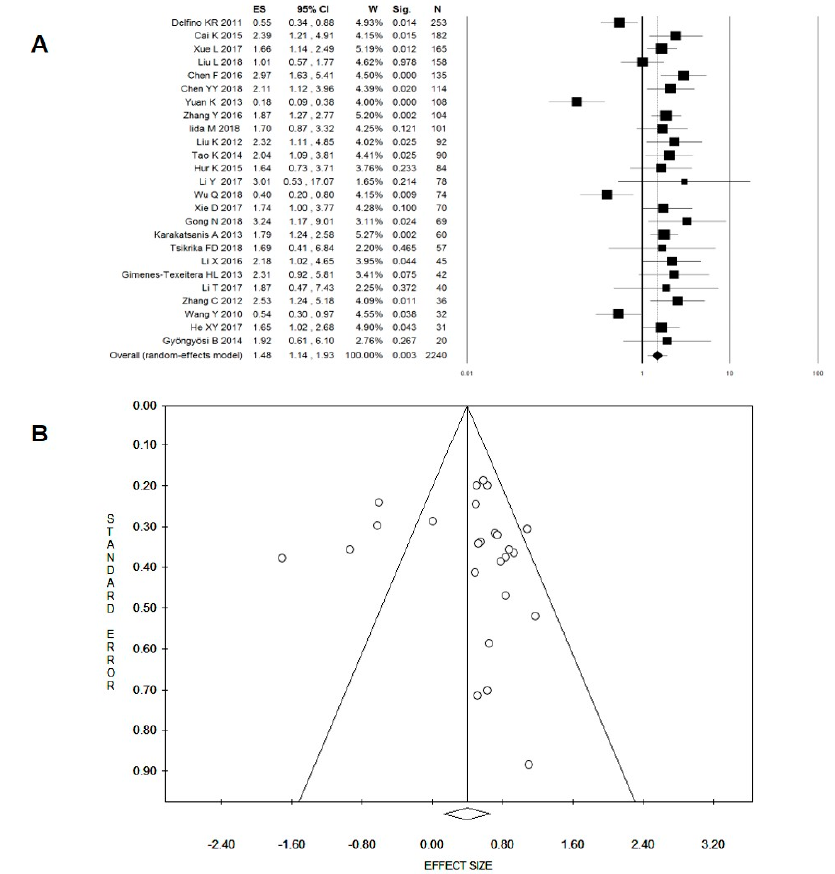
Figure 2. Forest ( A ) and Funnel ( B ) plots for the effect of miR-221 overexpression on overall survival. ES, effect size (i.e., hazard ratio); W, weight; Sig, statistical significance; N, total number of cancer patients included in the survival